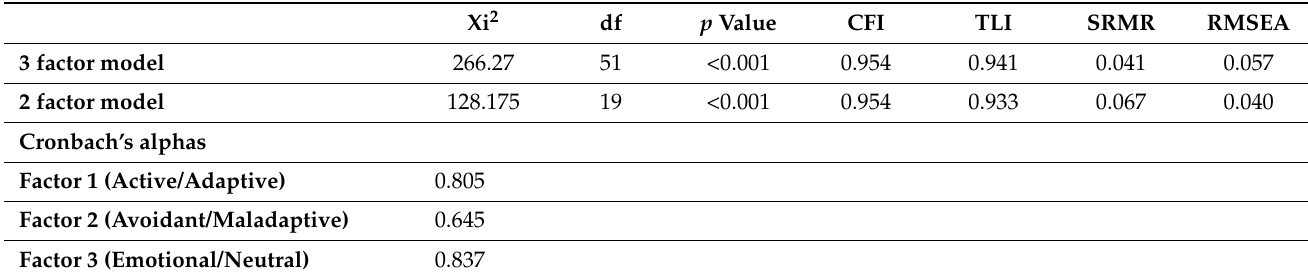
Table 2. A confirmatory factorial analysis of the factorial model and internal consistency.